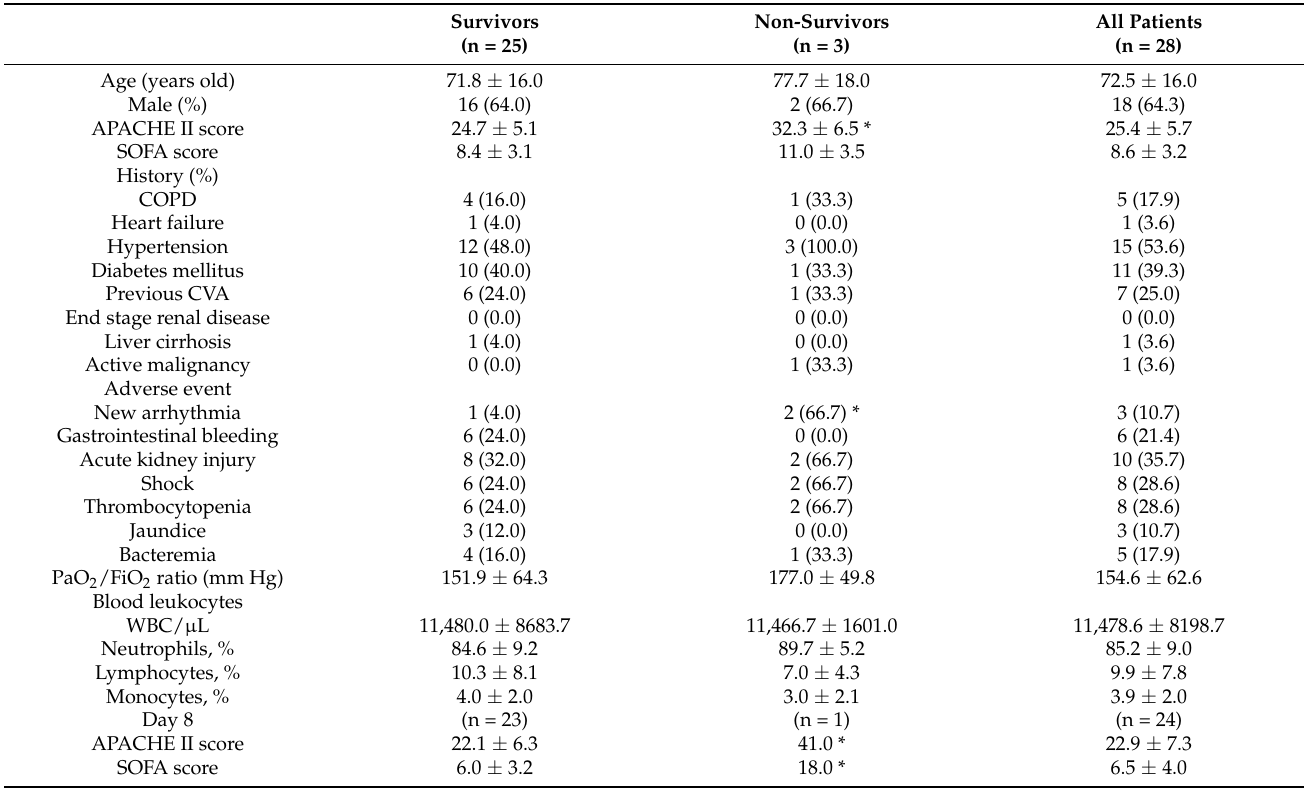
Table 1. Clinical characteristics of patients with ARDS (number, mean ± standard deviation).